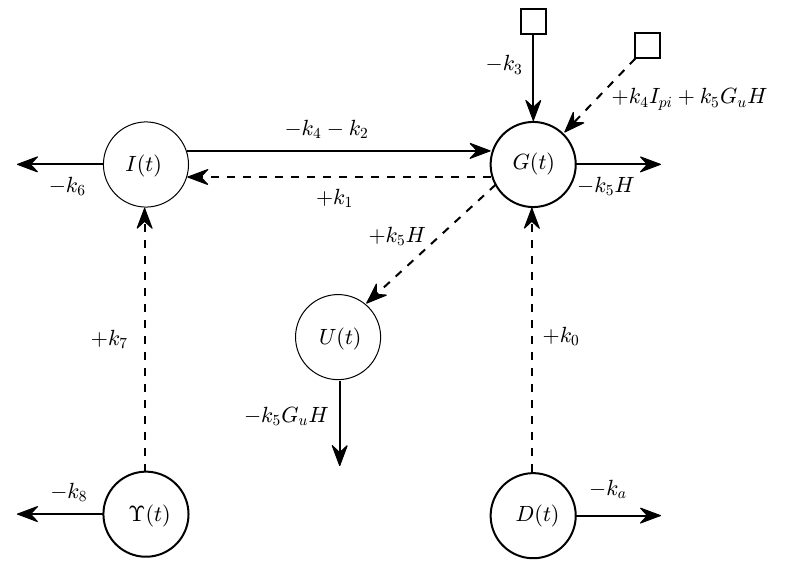
Figure 1. Graphical explanation of the contribution of each differential equation and its relationships with the